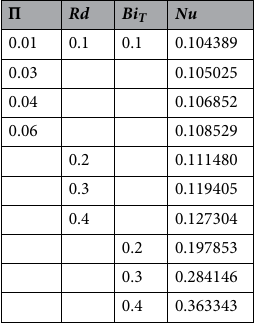
Table 5. Impacts of the embedded parameters on Nu